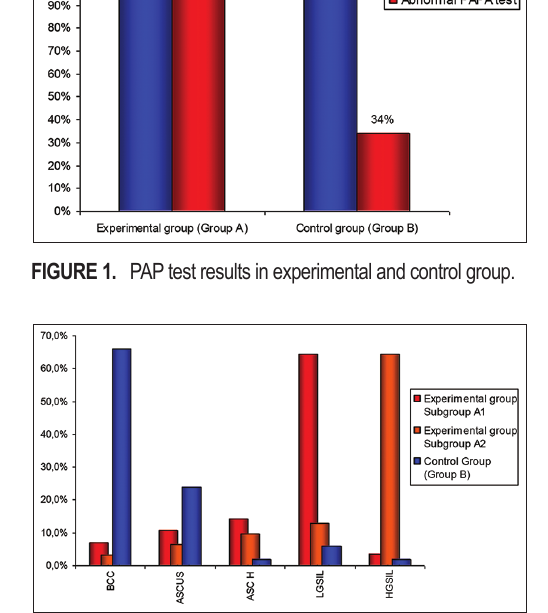
Figure 2. Results of PAP test compared to colposcopy